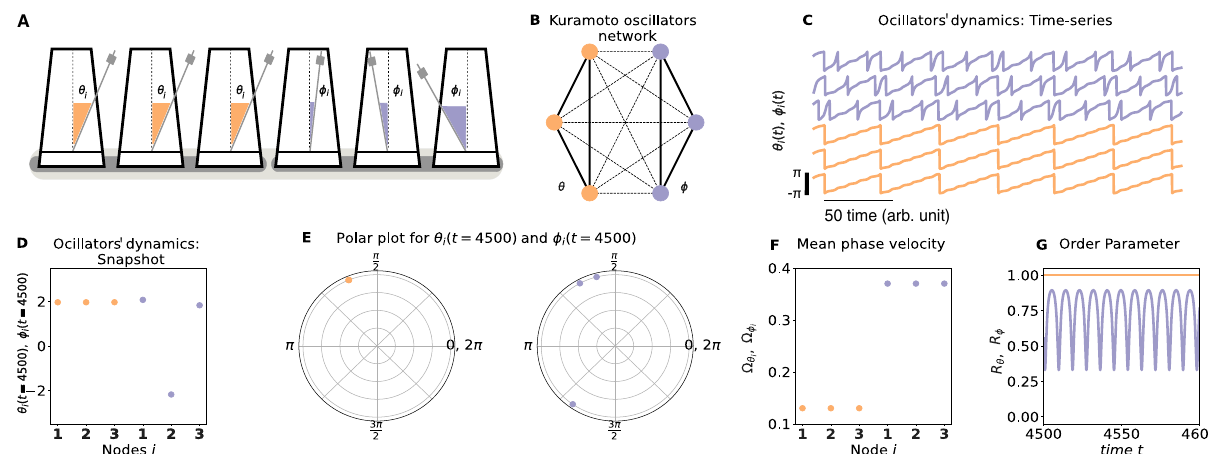
Fig. 1 Chimera state. A Schematic representation of the chimera state: each metronome represents an oscillator with phase θ i (orange or light gray for b/w printing, synchronous group) or ϕ i (purple or dark gray for b/w printing, asynchronous group). B Diagram showing the coupling scheme of the two groups ( n = 3): oscillators are coupled with strength μ within the same group and ν between groups, note that μ > ν . C Time-series of the 6 different oscillator's phases θ i (orange) and ϕ i (purple). D Snapshot of phases θ i and ϕ i for the 6 oscillators at t = 4500. E Same as panel D in polar coordinates. F Mean phase velocity pro fi le. G Trajectories of the order parameter for both